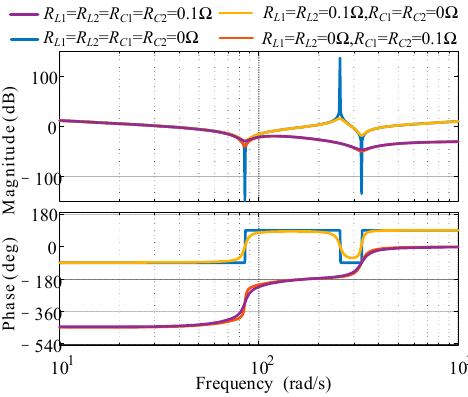
Figure 8. Frequency response characteristics of output admittance in DC filter networks.